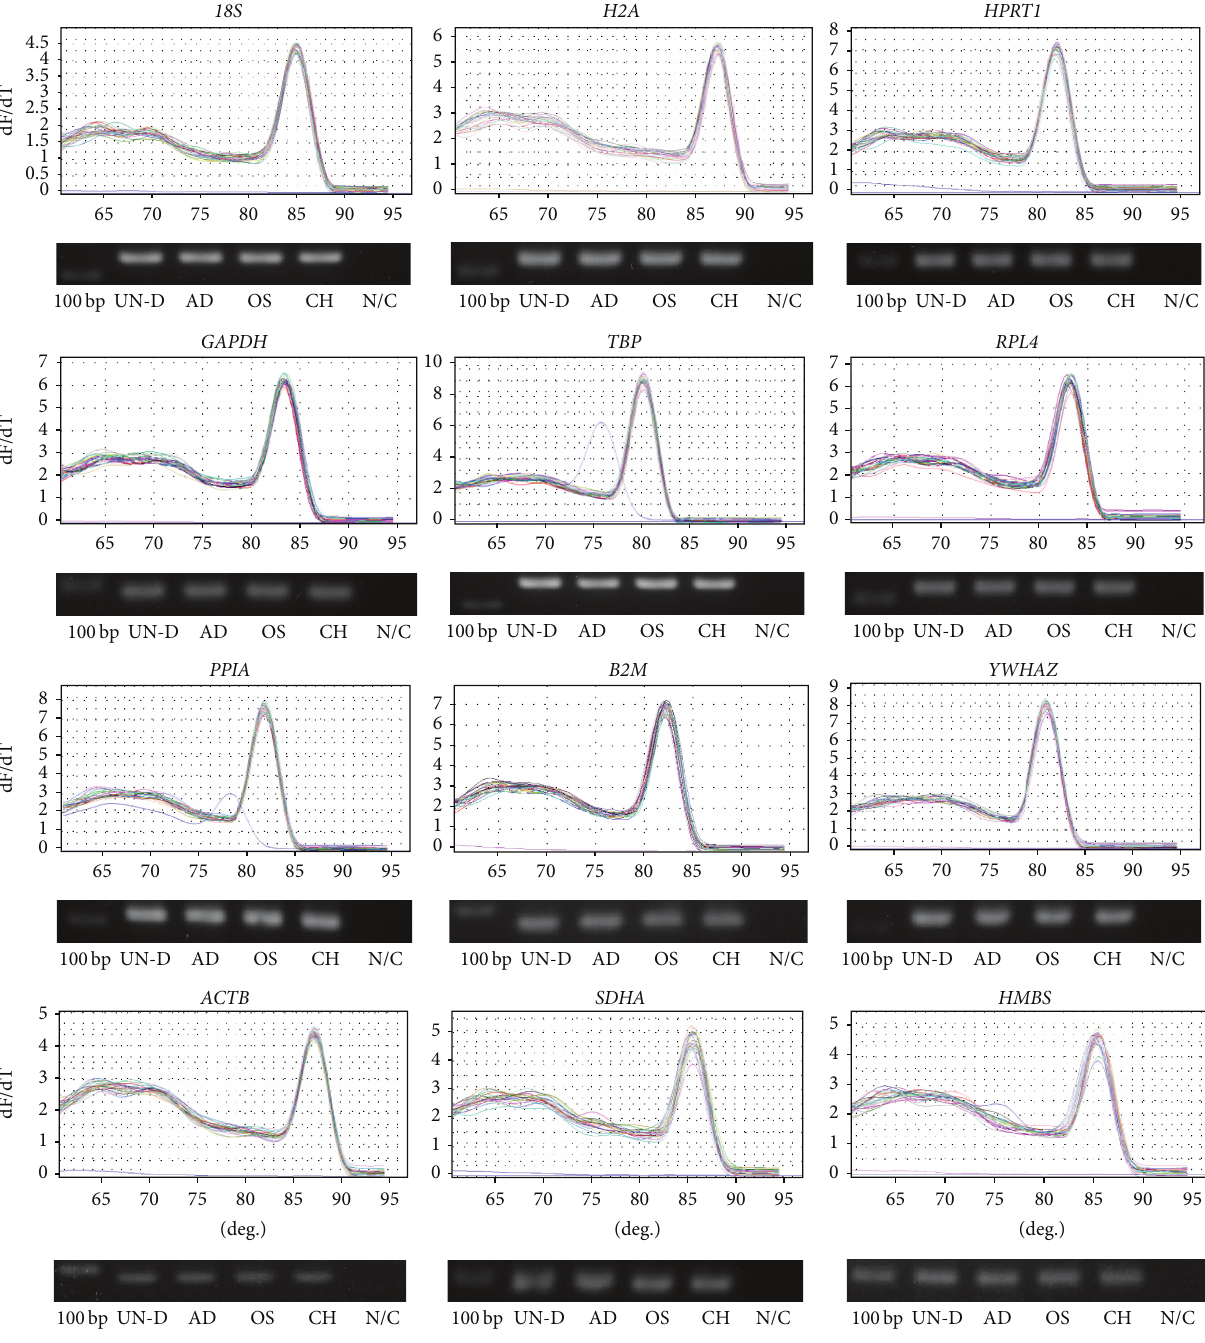
Figure 3: Confirmation of primer specificity and amplicon size in various MSCs with selected reference genes. Each melting curve analysis of twelve selected reference genes was presented (top of individual genes) and each product of amplification was shown by agarose gel electrophoresis (bottom of individual genes). Lanes, which were displayed from the left to the right, showed 100 bp ladder, undifferentiated MSCs, and differentiated cells into adipocytes or osteoblasts or chondrocytes, respectively. UN-D: undifferentiated MSCs; AD: adipogenesis; OS: osteogenesis; CH: chondrogenesis; N/C: negative